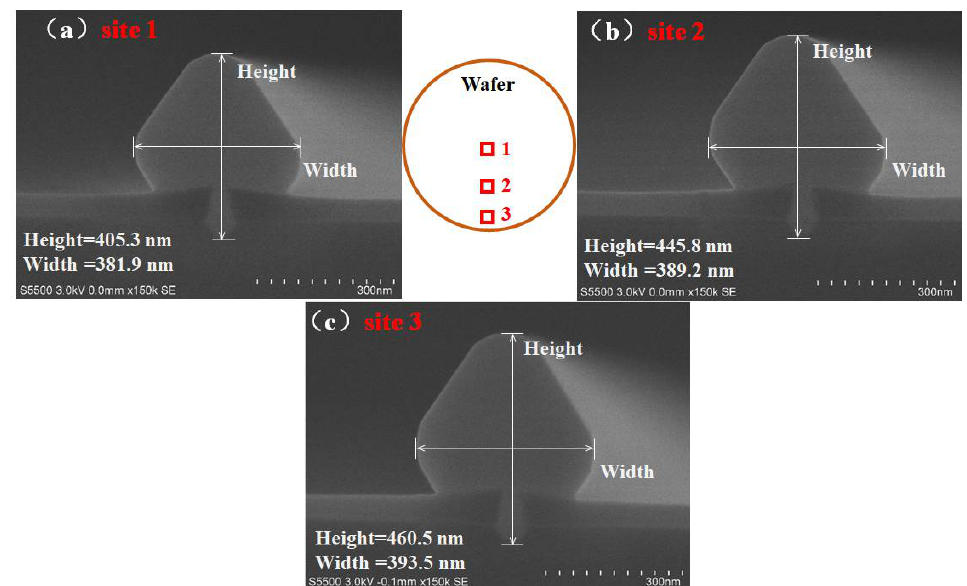
Figure 6. Cross-section of selectively grown Ge selected in different parts of the wafer: ( a ) site 1, the center; ( b ) site 2, between the center and edge; ( c ) site 3, the edge. The main reason behind the pattern dependency is the gas consumption over the chip.